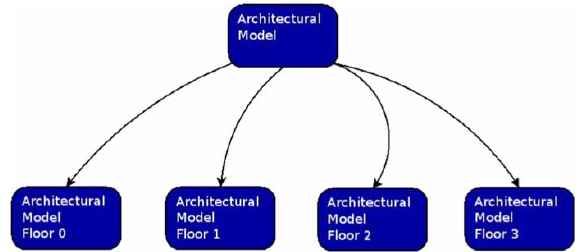
Fig. 3. Composition